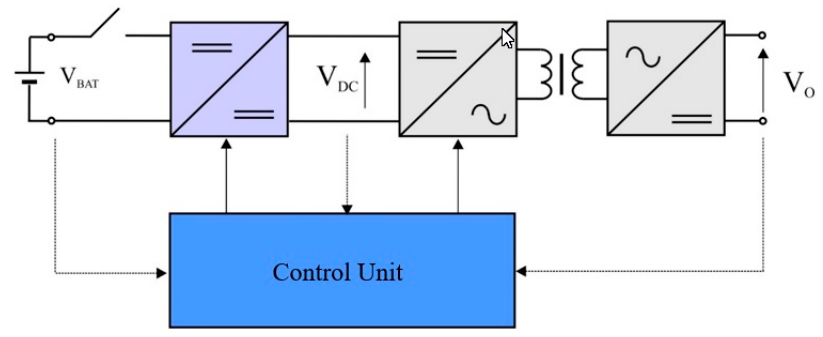
Figure 3. Overall scheme of the portable DC power supply.